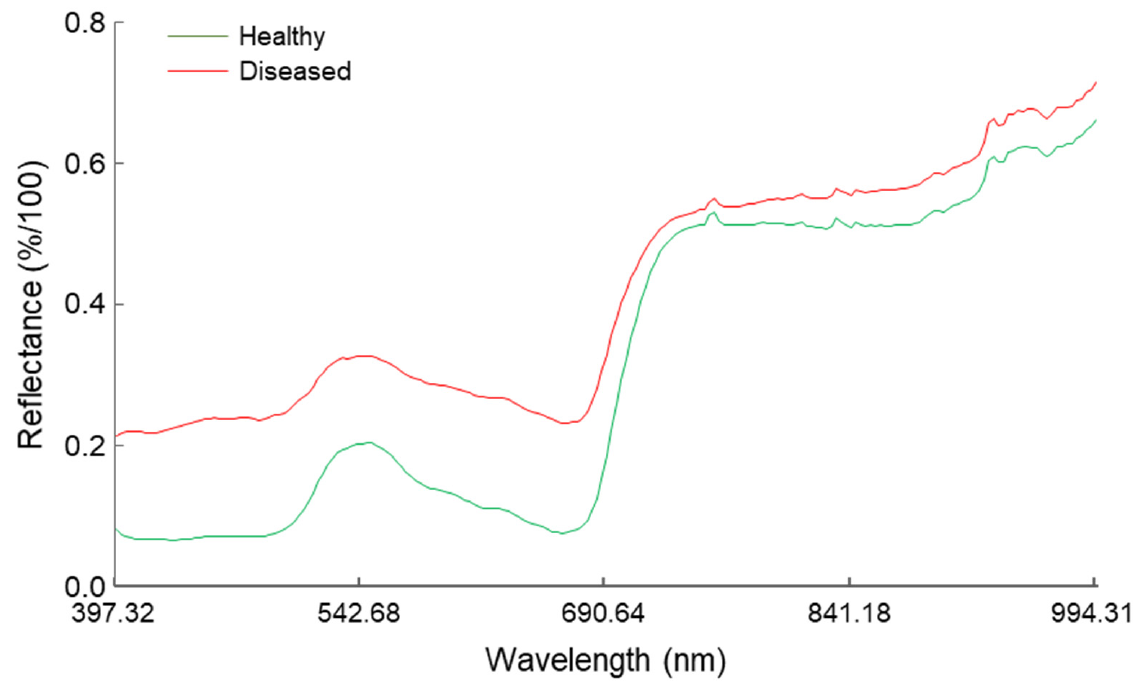
Figure 6. Comparison of the hyperspectral reflectance curves of the healthy and infected samples.